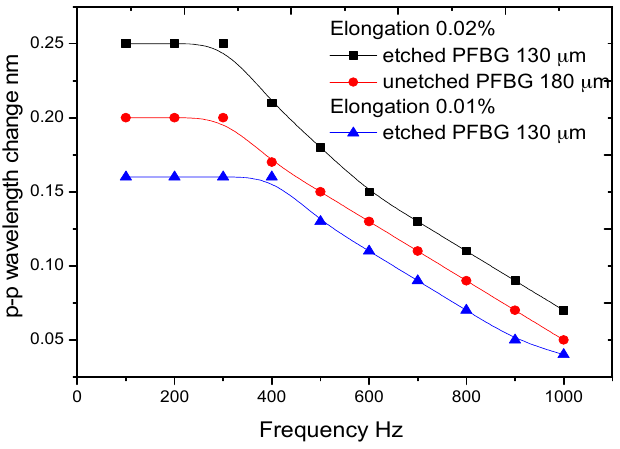
Figure 9. Dynamic strain characteristics of etched and unetched PFBGs.